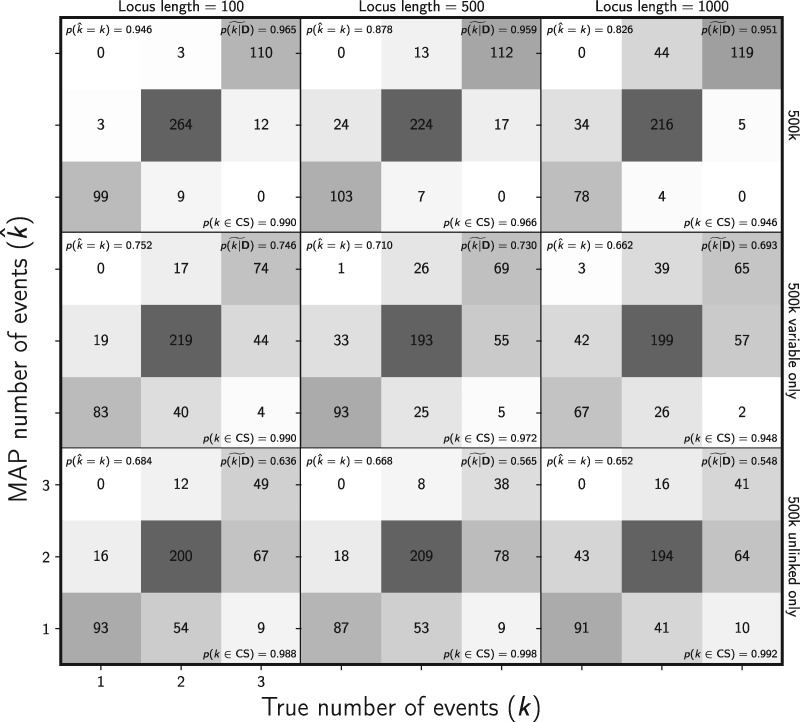
Assessing the effect of linked sites on the ability of the new method to estimate the number of divergence events. The columns, from left to right, show the results when loci are simulated with 100, 500, and 1000 linked sites. For each simulated data set, each of three population pairs has 500,000 sites total. The rows show the results when (top) all sites, (middle) all variable sites, and (bottom) at most one variable site per locus are analyzed. The number of data sets that fall within each possible cell of true versus estimated numbers of events is shown, and cells with more data sets are shaded darker. The estimates are based on the number of events with the maximum a posteriori (MAP) probability. For each plot, the proportion of data sets for which the number of events with the largest posterior probability matched the true number of events—\documentclass[12pt]{minimal}
\usepackage{amsmath}
\usepackage{wasysym}
\usepackage{amsfonts}
\usepackage{amssymb}
\usepackage{amsbsy}
\usepackage{upgreek}
\usepackage{mathrsfs}
\setlength{\oddsidemargin}{-69pt}
\begin{document}
}{}$p(\hat{{k}} = {k})$\end{document}—is shown in the upper left corner, the median posterior probability of the correct number of events across all data sets—\documentclass[12pt]{minimal}
\usepackage{amsmath}
\usepackage{wasysym}
\usepackage{amsfonts}
\usepackage{amssymb}
\usepackage{amsbsy}
\usepackage{upgreek}
\usepackage{mathrsfs}
\setlength{\oddsidemargin}{-69pt}
\begin{document}
}{}$\widetilde{p({k}|{\mathbf{D}})}$\end{document}—is shown in the upper right corner, and the proportion of data sets for which the true number of events was included in the 95% credible set—\documentclass[12pt]{minimal}
\usepackage{amsmath}
\usepackage{wasysym}
\usepackage{amsfonts}
\usepackage{amssymb}
\usepackage{amsbsy}
\usepackage{upgreek}
\usepackage{mathrsfs}
\setlength{\oddsidemargin}{-69pt}
\begin{document}
}{}$p({k} \in \textrm{CS})$\end{document}—is shown in the lower right. We generated the plot using matplotlib Version 2.0.0 (Hunter 2007)